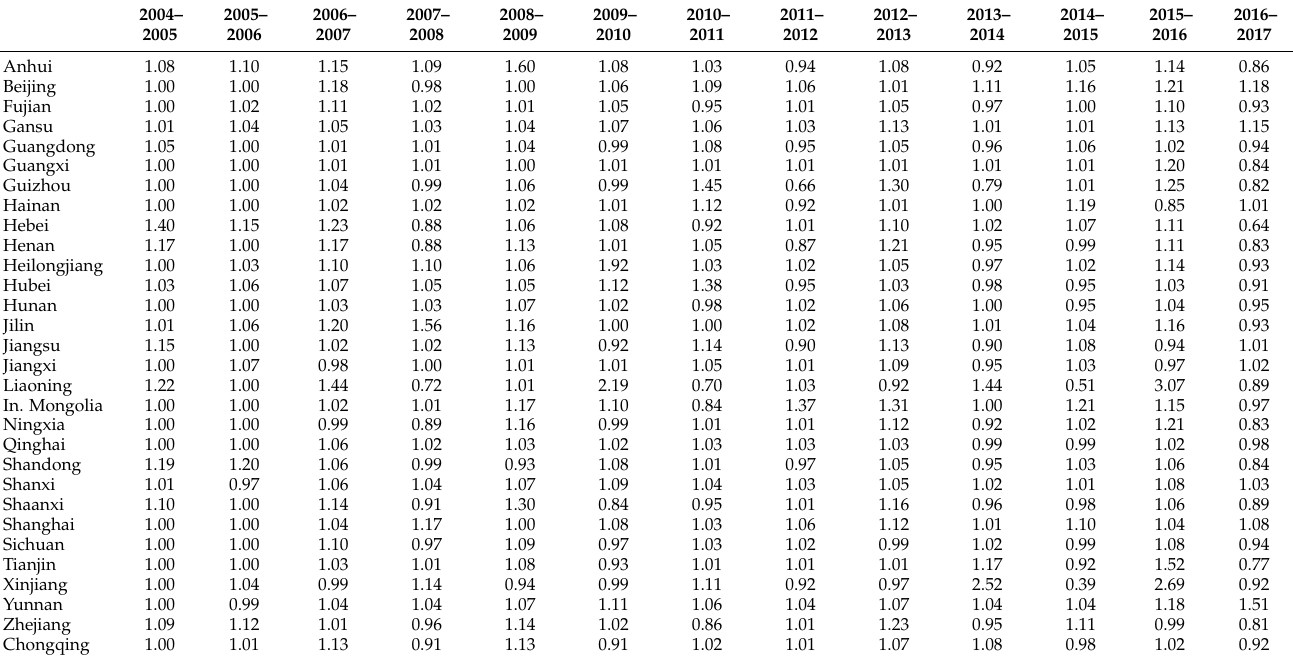
Table 7. Changes in technological progress index for ecological use of agricultural land in 30 provinces in